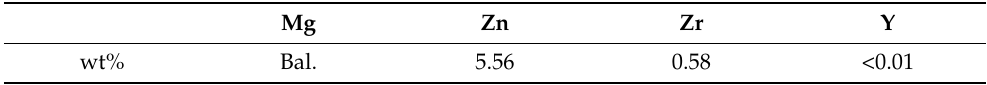
Table 1. The chemical composition of ZK60 Mg